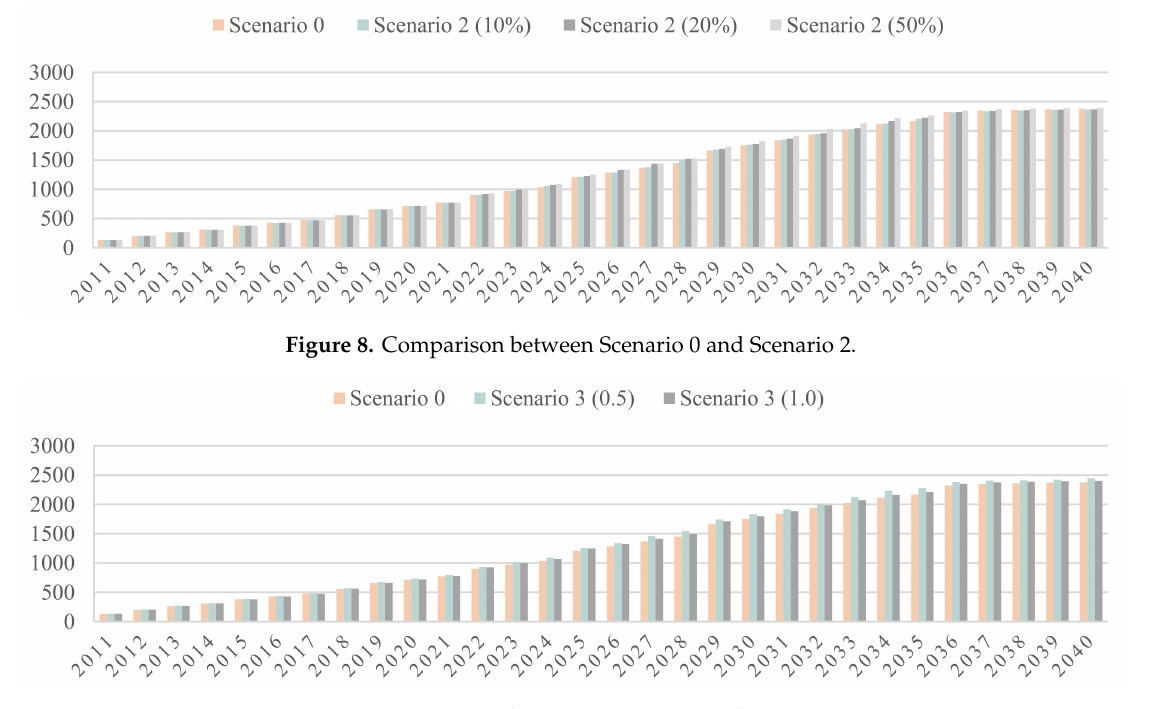
Figure 9. Comparison between Scenario 0 and Scenario 3.